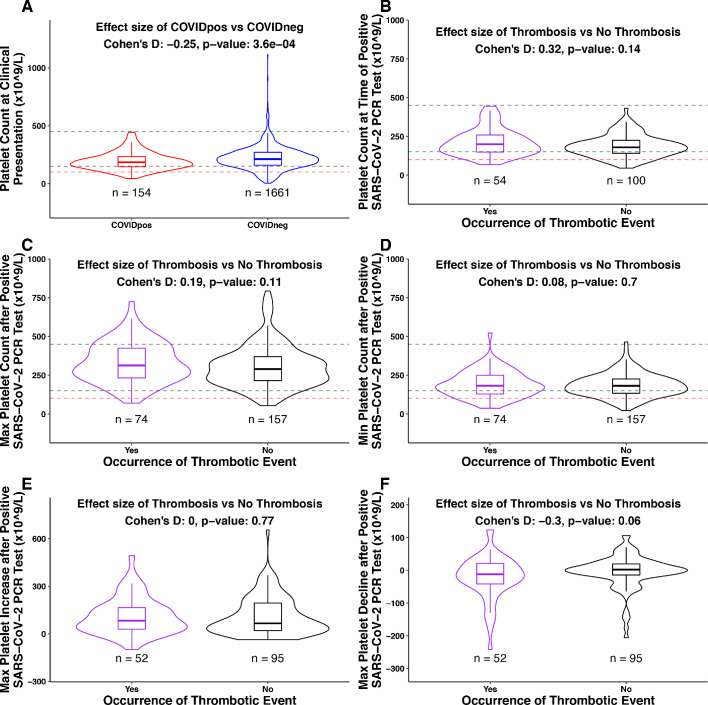
Association between platelet counts and thrombosis in the COVIDpos cohort.Box plots of platelet counts, min/max values, and maximum levels of increase/decline at specific time intervals for COVIDpos and COVIDneg cohorts and subgroups of the COVIDpos cohort with and without thrombotic events after SARS-CoV-2 diagnosis. In the subplot (A), we show platelet counts for COVIDpos (red) and COVIDneg (blue) cohorts. In subplots (B-F), we show platelet counts for COVIDpos patients who did and did not subsequently develop thromboses (purple and black, respectively). Horizontal dotted gray lines correspond to upper and lower limits of normal platelet counts (150−450 × 109/L), and horizontal red line shows 100 × 109/L. At the top of each plot, Cohen’s D effect size and p-value from the Mann-Whitney statistical test are shown. (A) Platelet counts at the time of PCR testing for COVIDpos and COVIDneg cohorts. (B) Platelet counts at the time of PCR testing for COVIDpos patients who did and did not subsequently develop thromboses. (C) Maximum platelet counts (considering counts at and after positive PCR test date) for COVIDpos patients who did and did not subsequently develop thromboses. (D) Minimum platelet counts (considering counts at and after positive PCR test date) for COVIDpos patients who did and did not subsequently develop thromboses. (E) Maximum degree of platelet increases after positive PCR test date for COVIDpos patients who did and did not subsequently develop thromboses. (F) Maximum degree of platelet declines after positive PCR test date for COVIDpos patients who did and did not subsequently develop thromboses.